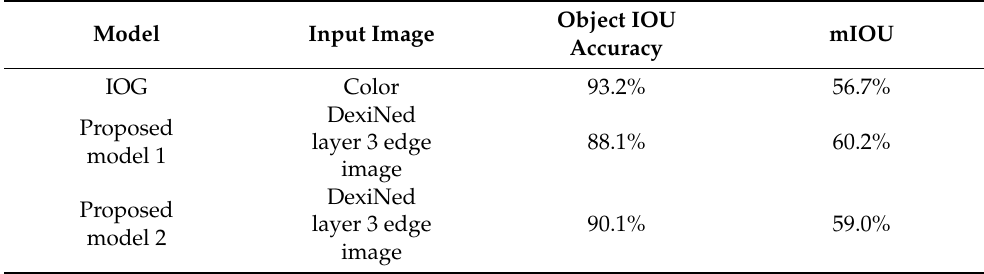
Table 7. The IOU accuracy of object and part segmentation for each interactive segmentation